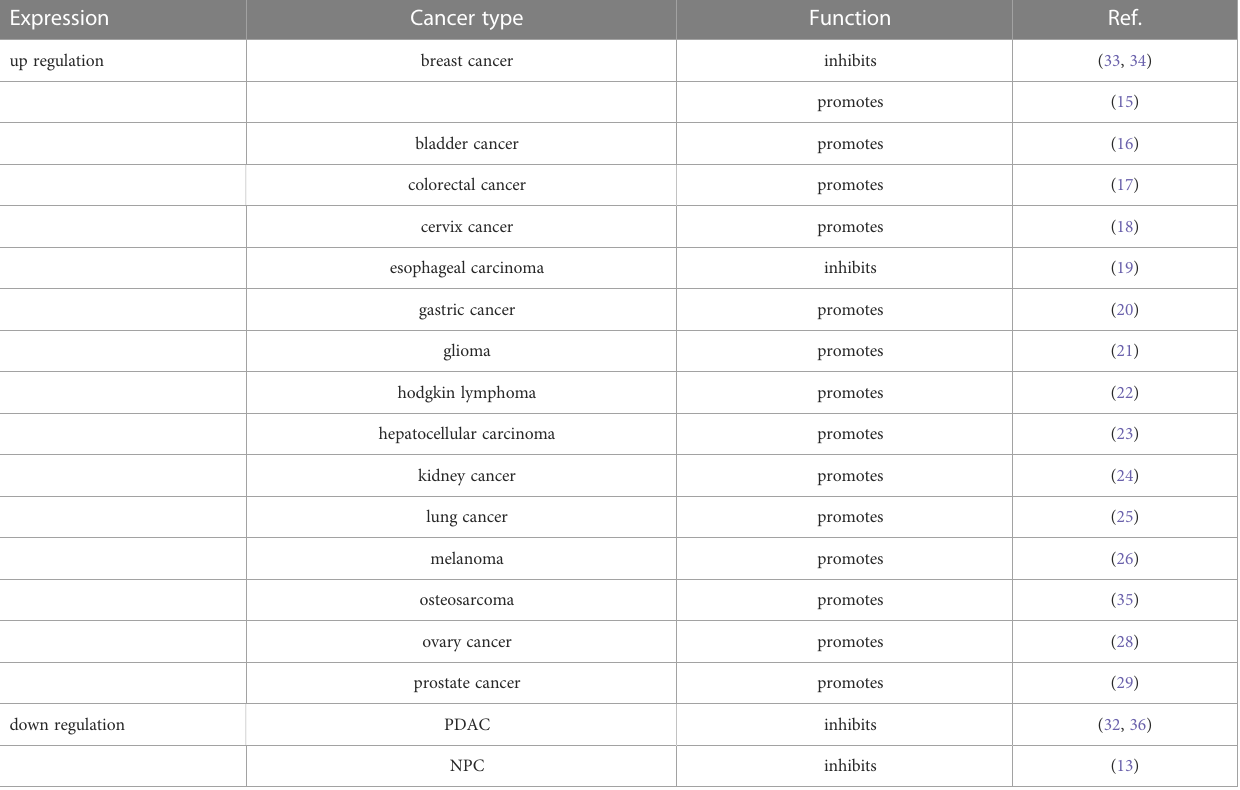
TABLE 1 Expression pro fi le and function of YY1 in a variety of tumors. Expression Cancer